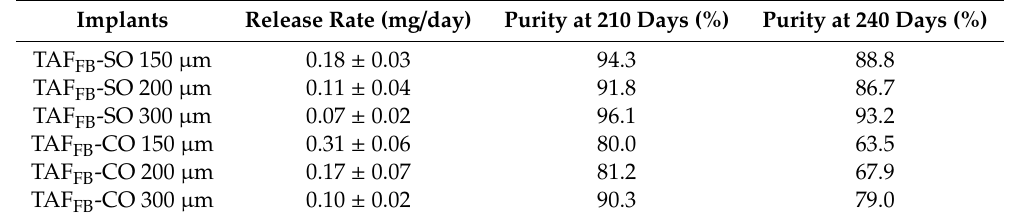
Figure 10. Cumulative release profiles of TAF FB -CO ( a ) and TAF FB -SO ( b ) formulations from implants of differing wall thicknesses. All samples were performed in triplicate. Table 4. The chromatographic purities of TAF FB -SO and TAF FB -CO formulations within implants of differing wall thicknesses at 210 and 240 days.